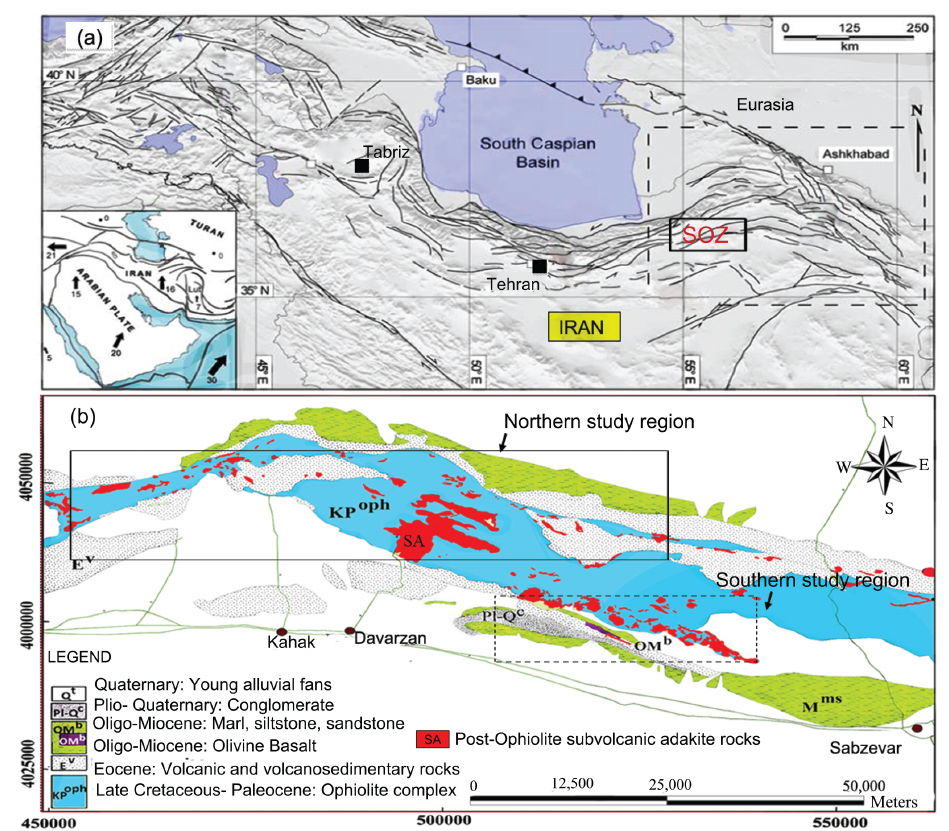
Figure 1. (a) Shaded relief image (after Shabanian et al., 2012) showing the location of the Sabzevar ophiolitic zone (SOZ). The lower left inset shows the geodynamic setting of Arabia–Eurasia collision/subduction framework. Black arrows and associated numbers represent the present-day Arabia–Eurasia plate movement velocities according to Reilinger et al. (2006) in mmyr − 1 . (b) Simplified geological map of the Sabzevar area and the post-ophiolite subvolcanic rocks. The northern (solid rectangle) and southern (dashed rectangle) sector of the study area are